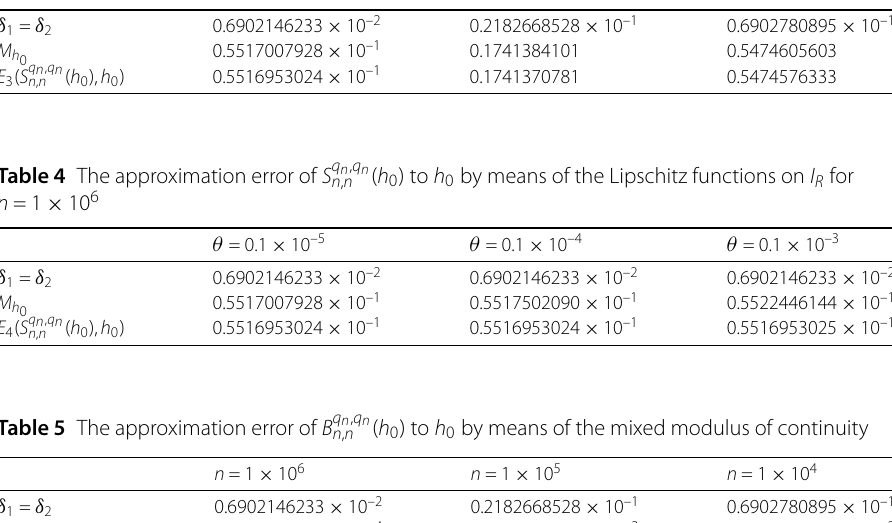
q 1, n 1 , q 2, n 2 n 1 , n 2